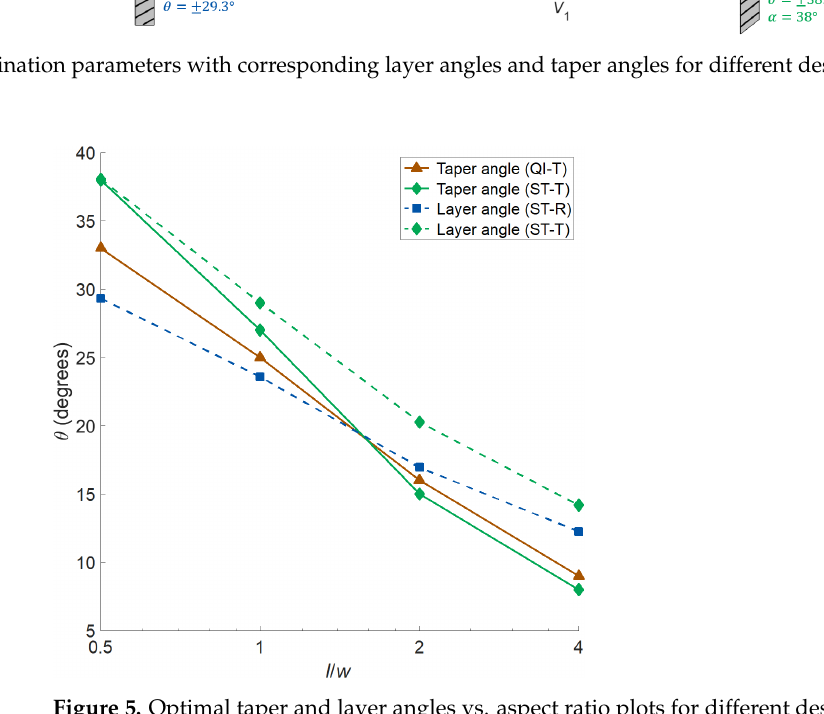
Figure 5. Optimal taper and layer angles vs. aspect ratio plots for different design